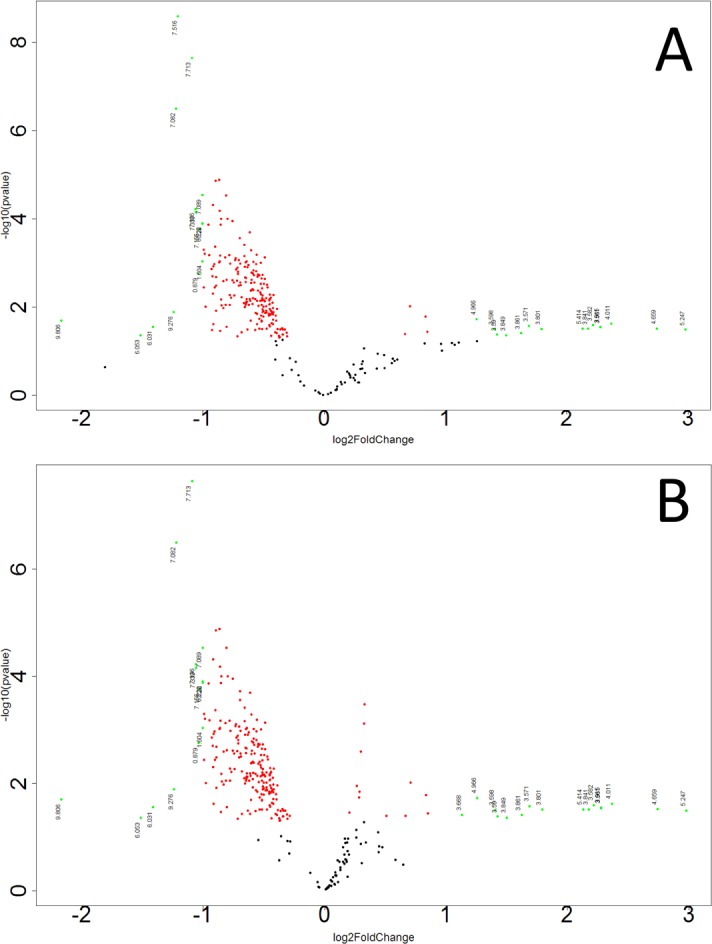
Volcano plot analysis of unidentified buckets in urine samples from 15-month male study mice.The volcano plots are presented (A) male and (B) female sample analysis. Buckets are plotted as points with the Log2(Fold Change) along the x-axis and -Log(p-value) along the y-axis. Buckets with |Log2(Fold Change)|>1 and -Log(p-value) >1.3, i.e. p <0.05, are colored green. Buckets with |Log2(Fold Change)|<1 and -Log(p-value) >1.3, i.e. p <0.05, are colored red.